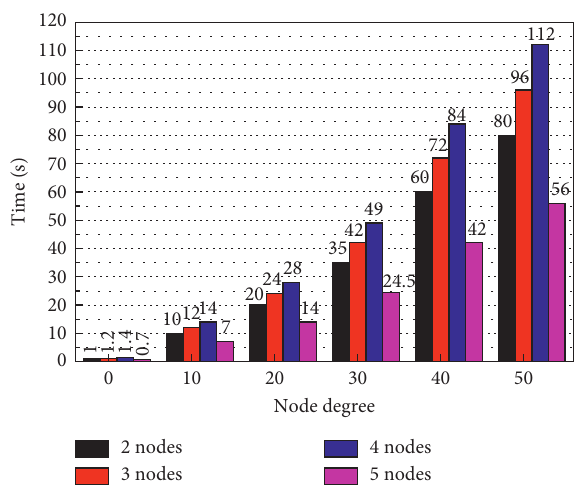
Figure 9: Simulation running time of system effectiveness experiment.